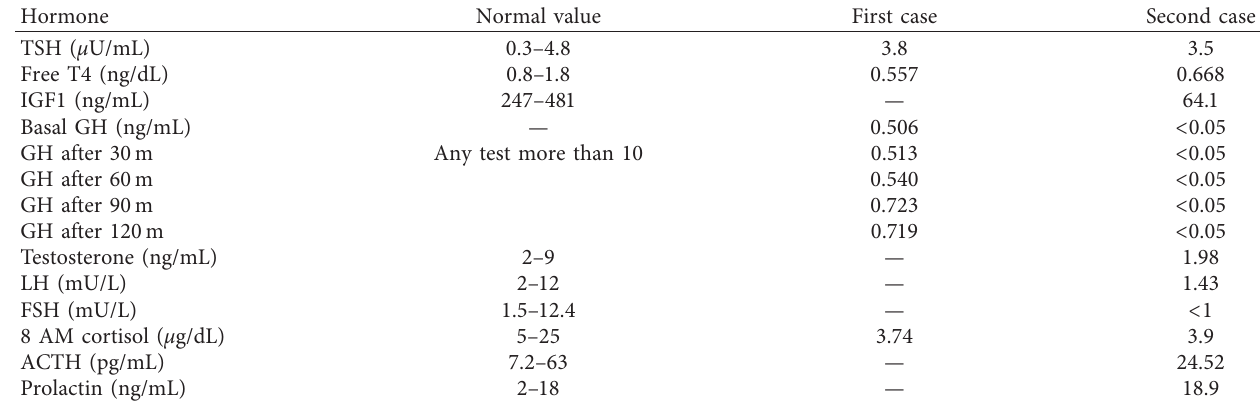
Table 2: Results of hormonal evaluation for both cases along with reference range.